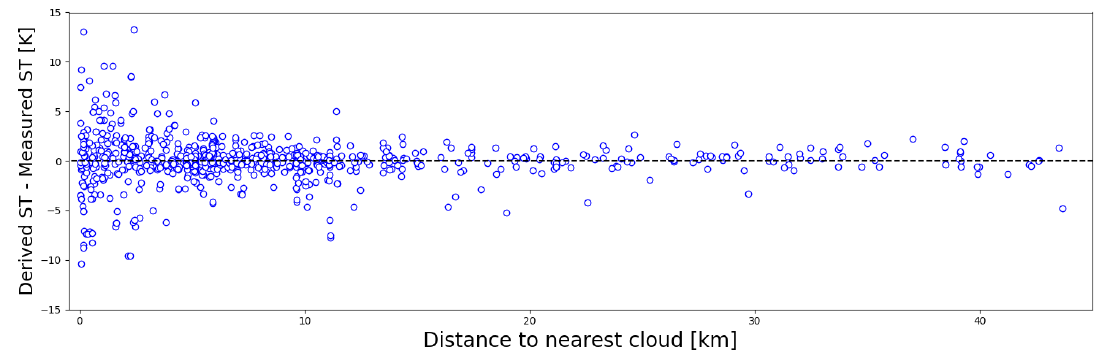
Figure 7. The difference between the reference temperature measurements and the Landsat-derived surface temperatures for the proposed split window methodology as a function of distance to nearest